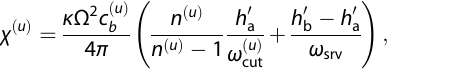
which for a π -pulse reduces to h a < π ϵ SE Ω . For a fi nite value of ω srv , the fi delity does not appreciably change from this asymptote in the h a -limited region, as seen in Fig. 3c. The maximum value of h a that